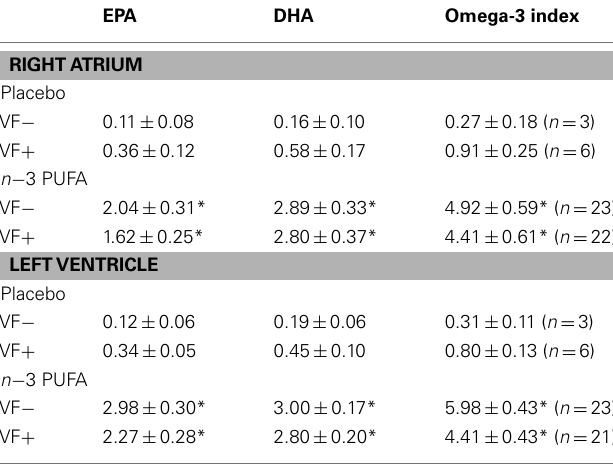
Table 2 | Cardiac tissue omega-3 polyunsaturated fatty acid content. Table 3 | Effect of dietary omega-3 polyunsaturated fatty acids on heart rate and heart rate